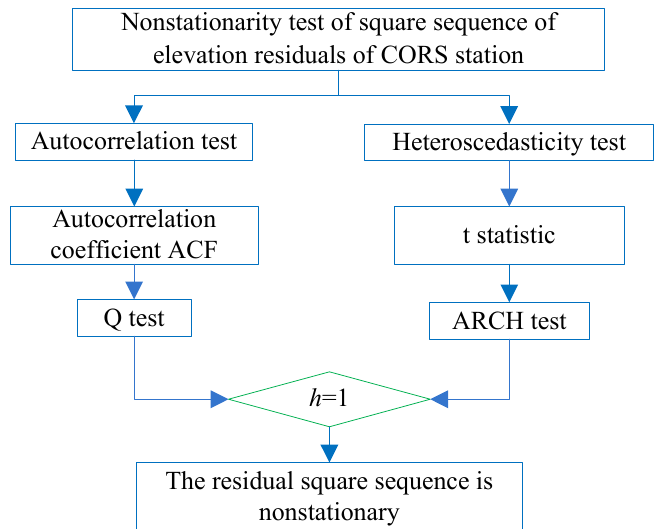
Figure 5. Non-stationarity test flow of CORS station elevation residual squared sequence.